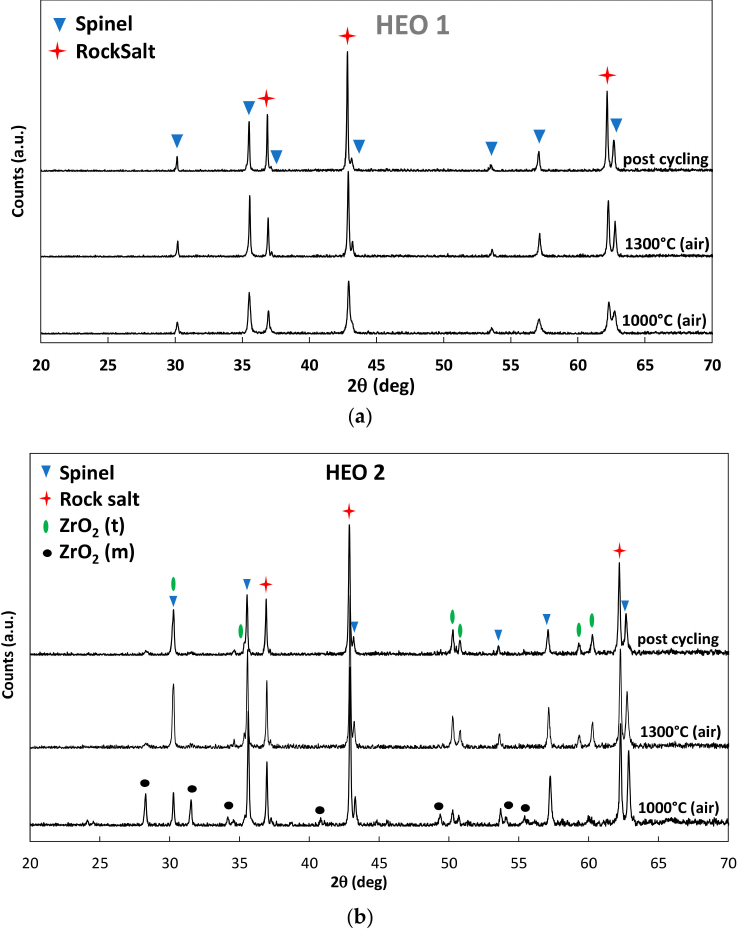
Figure 1. XRD patterns of ( a ) HEO 1 and ( b ) HEO 2 after calcination at 1000 ◦ C, 1300 ◦ C in air during 1 h and after two thermochemical cycles (post-cycling).